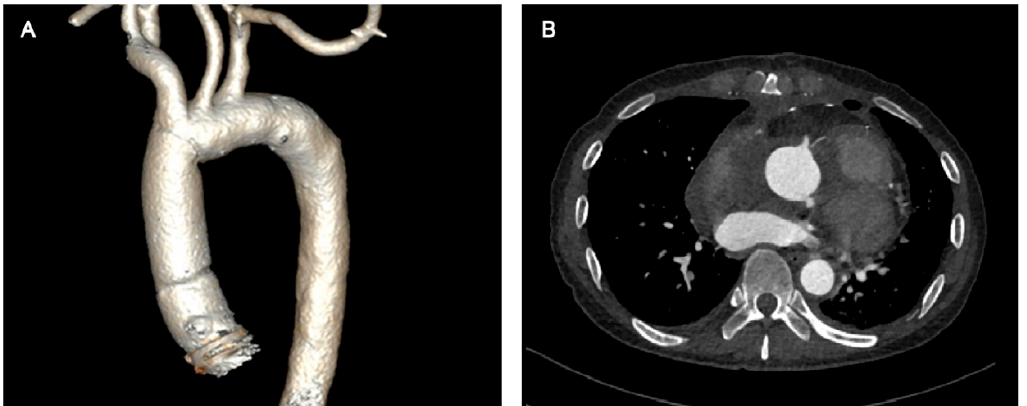
Figure 2. Postoperative aortic CTA scan revealed no leakage around the coronary ostia and an absence of pseudoaneurysm. ( A ) Three-dimensional reconstruction of aortic CTA; ( B ) Aortic CTA image at the coronary ostial level. CTA: computed tomographic angiography